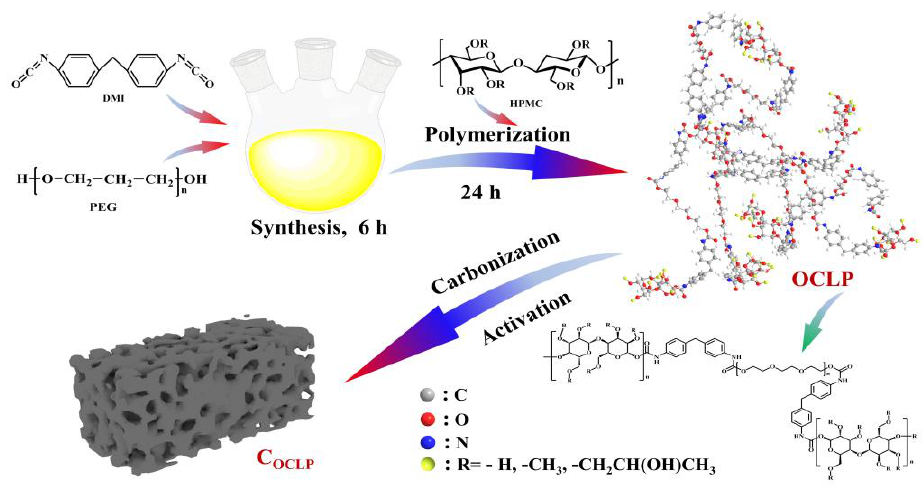
Figure 1. Schematic illustration of the one-pot method for the preparation of organic crosslinked polymer-derived porous